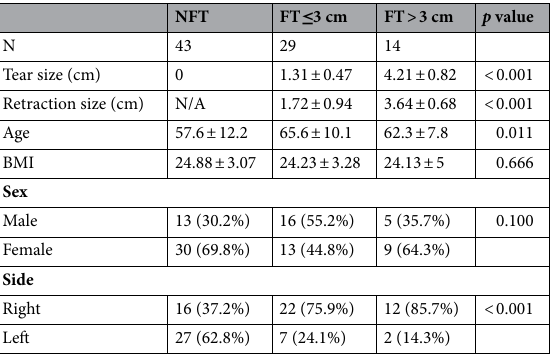
Table 2. Summarizes the demographic data according to tear size group. (NFT = non-full thickness tear, FT = full thickness tear). p value obtained by ANOVA test and Chi-square